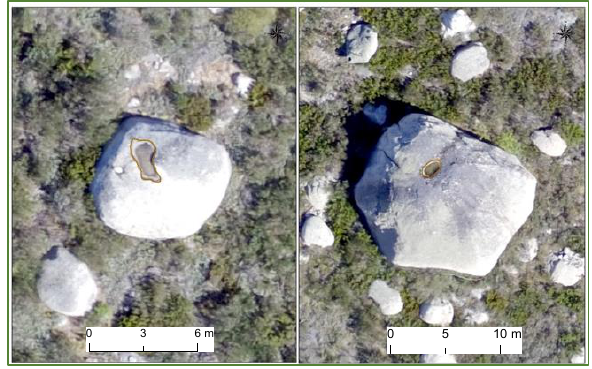
Figure 4. Individualization of weathering pits in granitic rock boulders - the Lagoa Seca geosite.